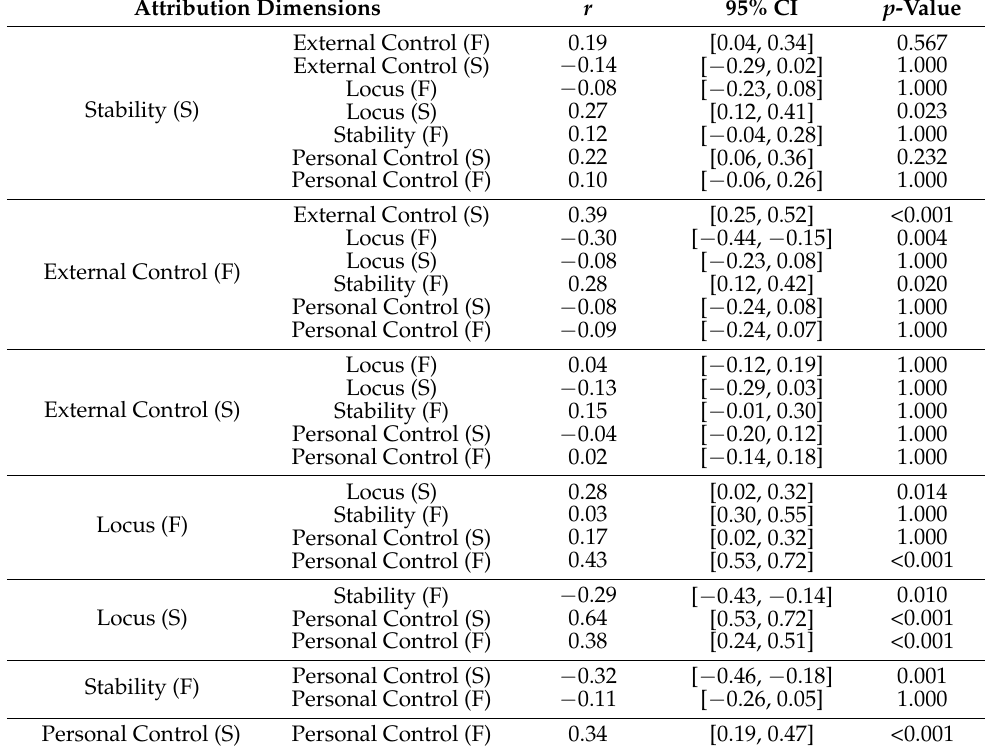
Table 3. Pearson correlations (r) with 95% confidence intervals (CI) amongst all attribution dimensions and both competitive events, success (S), and failure (F), with associated p -value. N = 154 for all